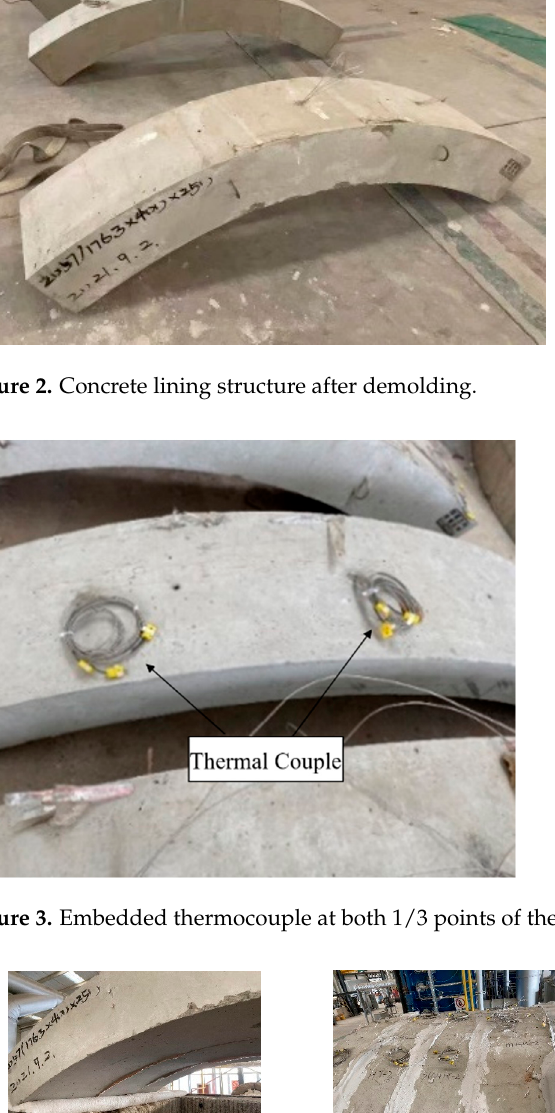
Figure 2. Concrete lining structure after demolding.